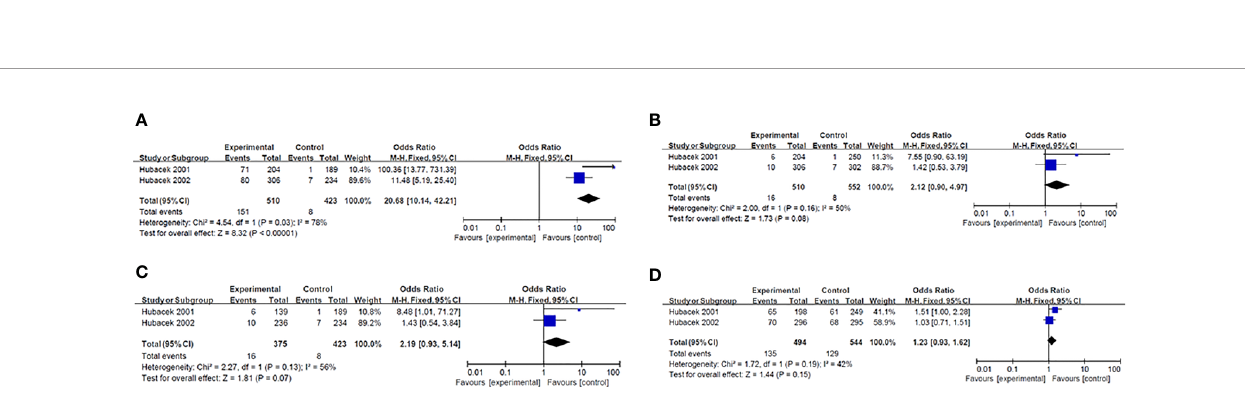
FIGURE 2 | Forest plot in synonymous 292. (A) Dominant model (TT+TG vs GG). (B) heterozygote model (TG vs GG). (C) homozygotes models (TT vs GG). (D) recessive models (TT vs TG